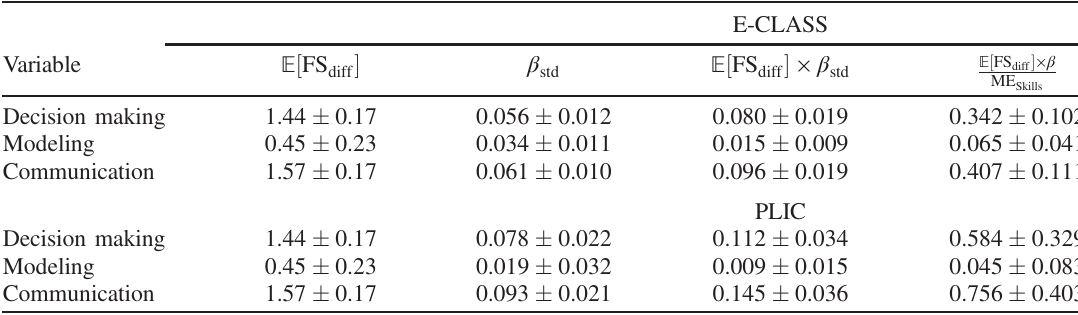
TABLE VIII. Estimate of the fraction of the observed effect of skills-based labs (compared to concepts-based labs) (cid:3) is the difference in average factor scores for skills-based that can be explained by the pedagogical variables. E ½ FS diff (cid:3) × β and concepts-based labs. β is the effect of the pedagogical variable on students ’ post-test scores. E ½ FS std diff std gives the expected difference in students ’ post-test scores between skills-based and concepts-based labs with average factor scores, and dividing this value by the marginal effect of skills-based labs (compared to concepts- based labs), ME , gives an estimate of the proportion of the effect of skills-based labs that can be attributed to Skills each pedagogical variable. Note that the decision-making and communication variables were modeled separately and so the effects of these variables are not additive; there is considerable overlap in the variance explained by these variables.